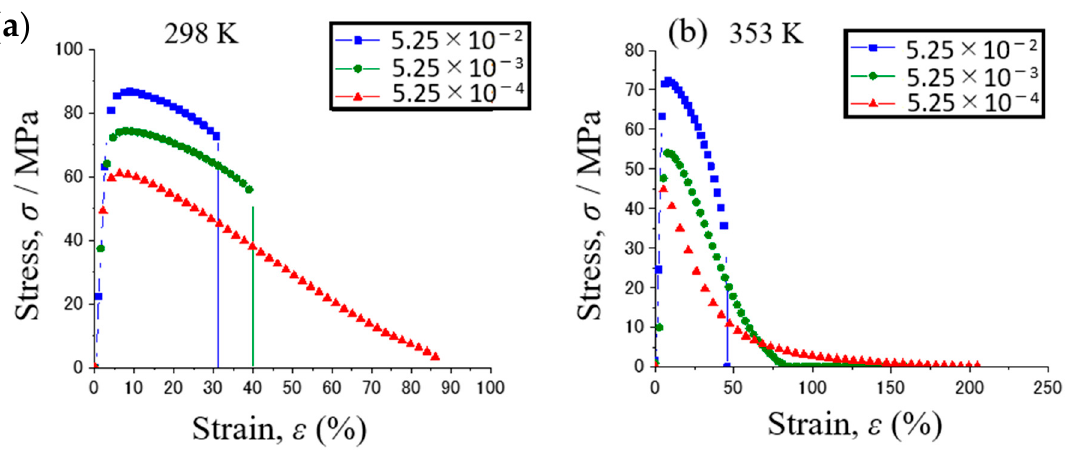
Figure 6. Stress–strain curves of Sn-40Bi-0.1Sb under various strain rates at ( a ) 298 and ( b ) 353 K.